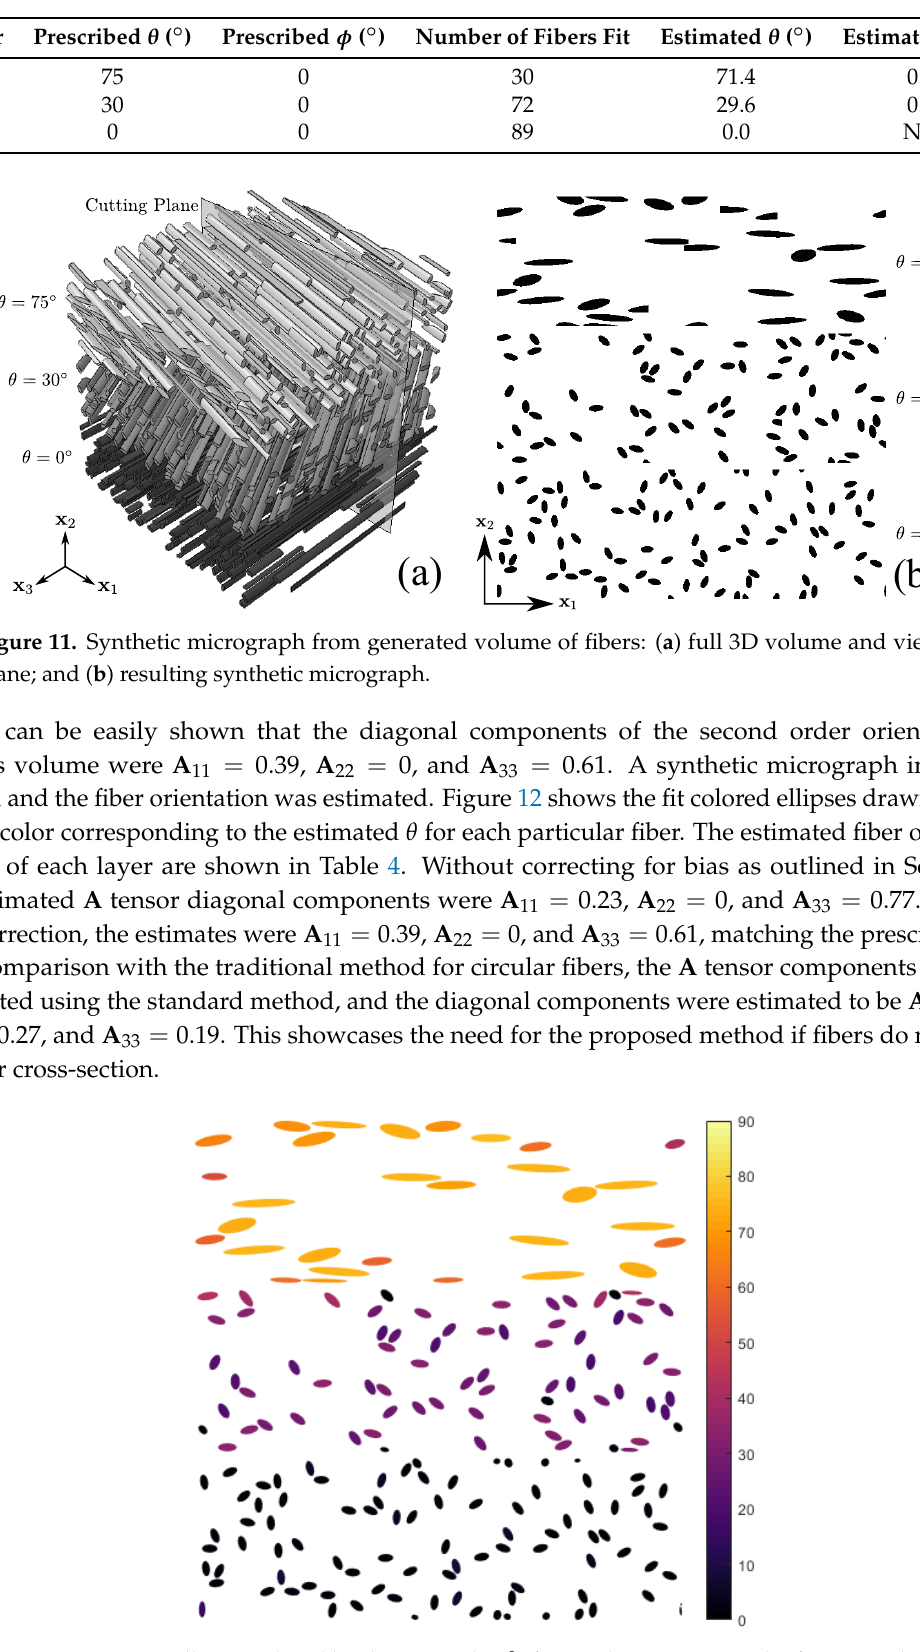
Figure 12. Fit ellipses colored by determined θ ( ◦ ) for synthetic micrograph of Figure